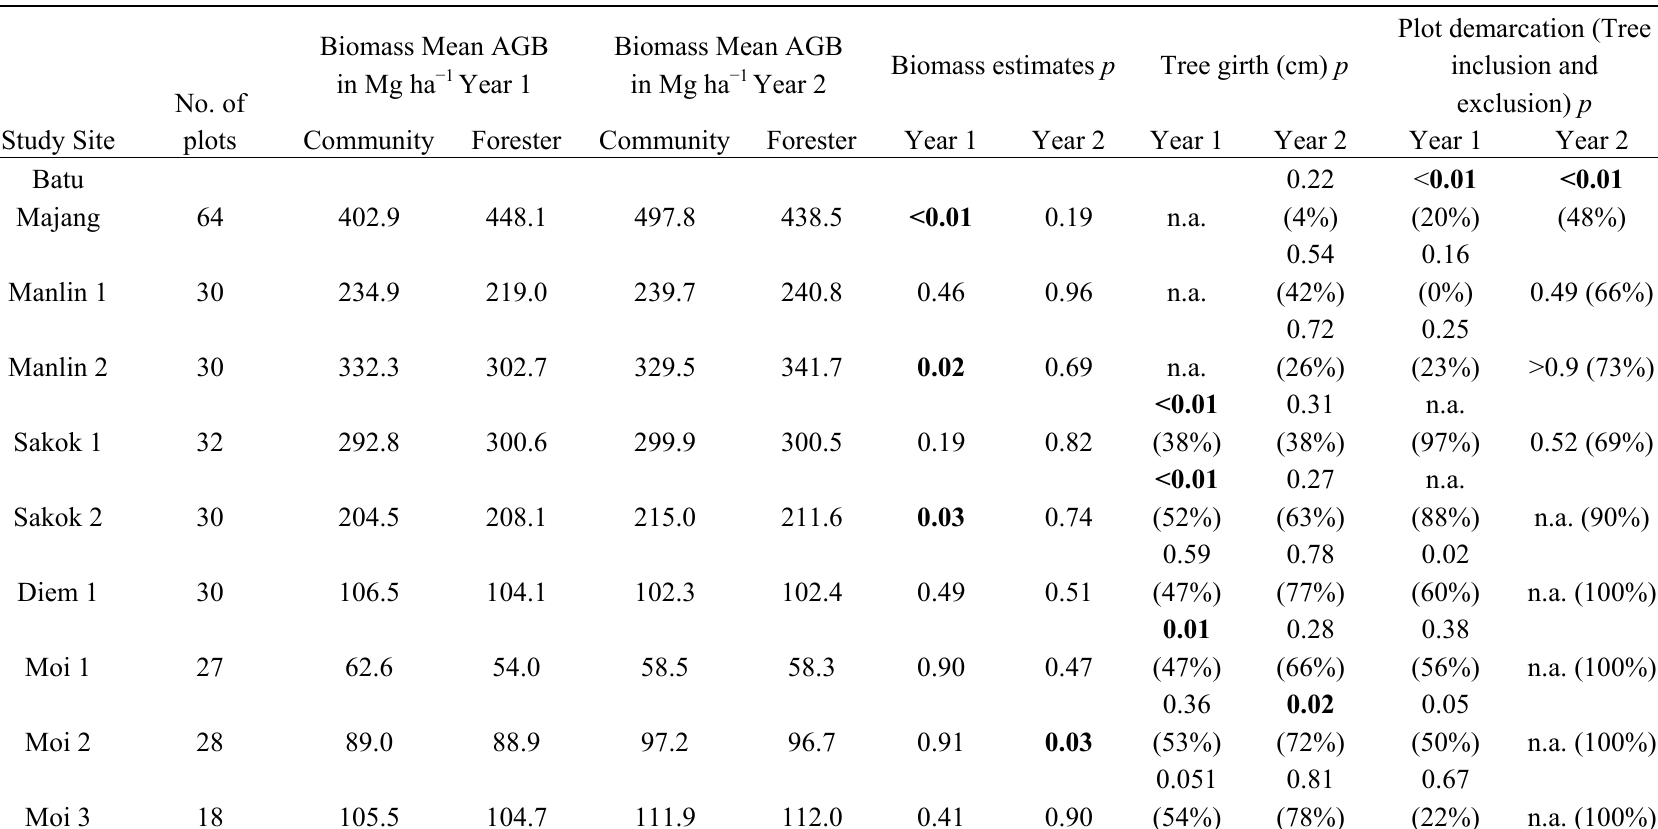
Table 1. Measurements of aboveground biomass by community members and professional foresters in four Southeast Asian countries, with p values for total AGB estimates (matched pair t test), tree DBH measurement (Wilcoxon signed rank test), and plot demarcation (Wilcoxon signed rank test) ( n = 289 permanent plots); percentages equals proportion of plots (inclusion and exclusion of trees) and trees (tree girth) where community members’ and professional foresters’ measurements matched perfectly; n.a.—not available or too few degrees of freedom for